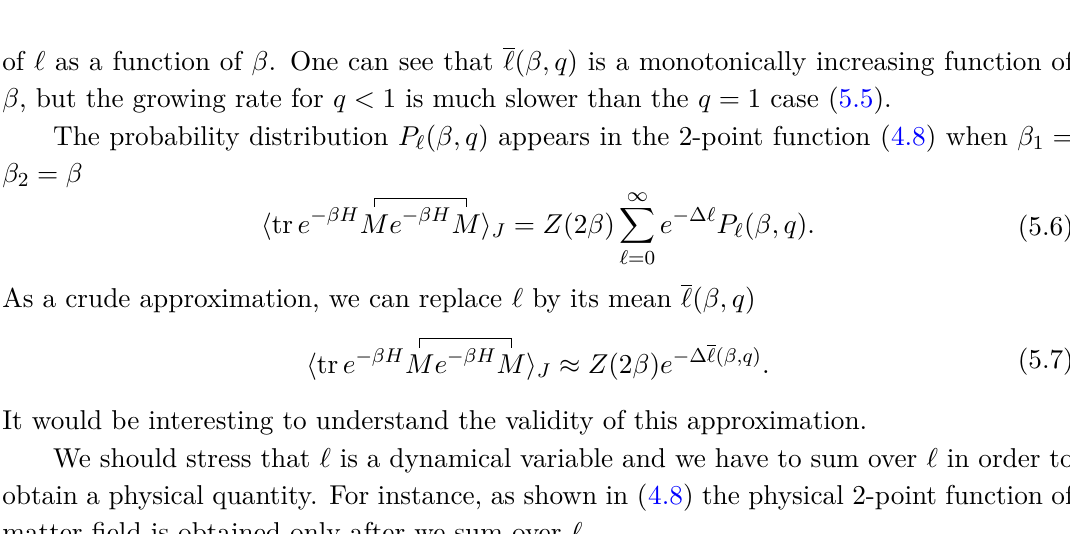
Figure 2. Plot of ‘ ( β, q ) against β with fixed q